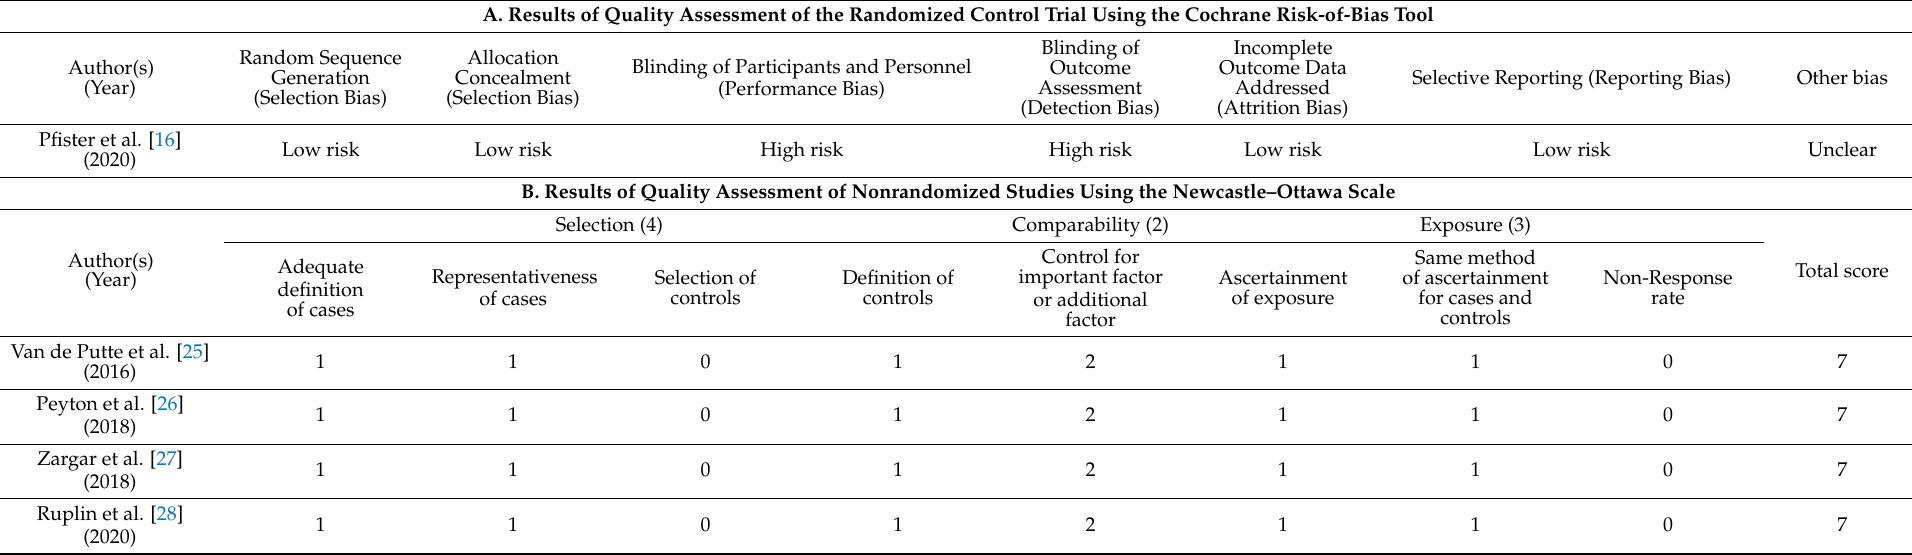
Table 2. Results of quality assessment using the Cochrane risk-of-bias tool and Newcastle–Ottawa scale. A. Results of Quality Assessment of the Randomized Control Trial Using the Cochrane Risk-of-Bias